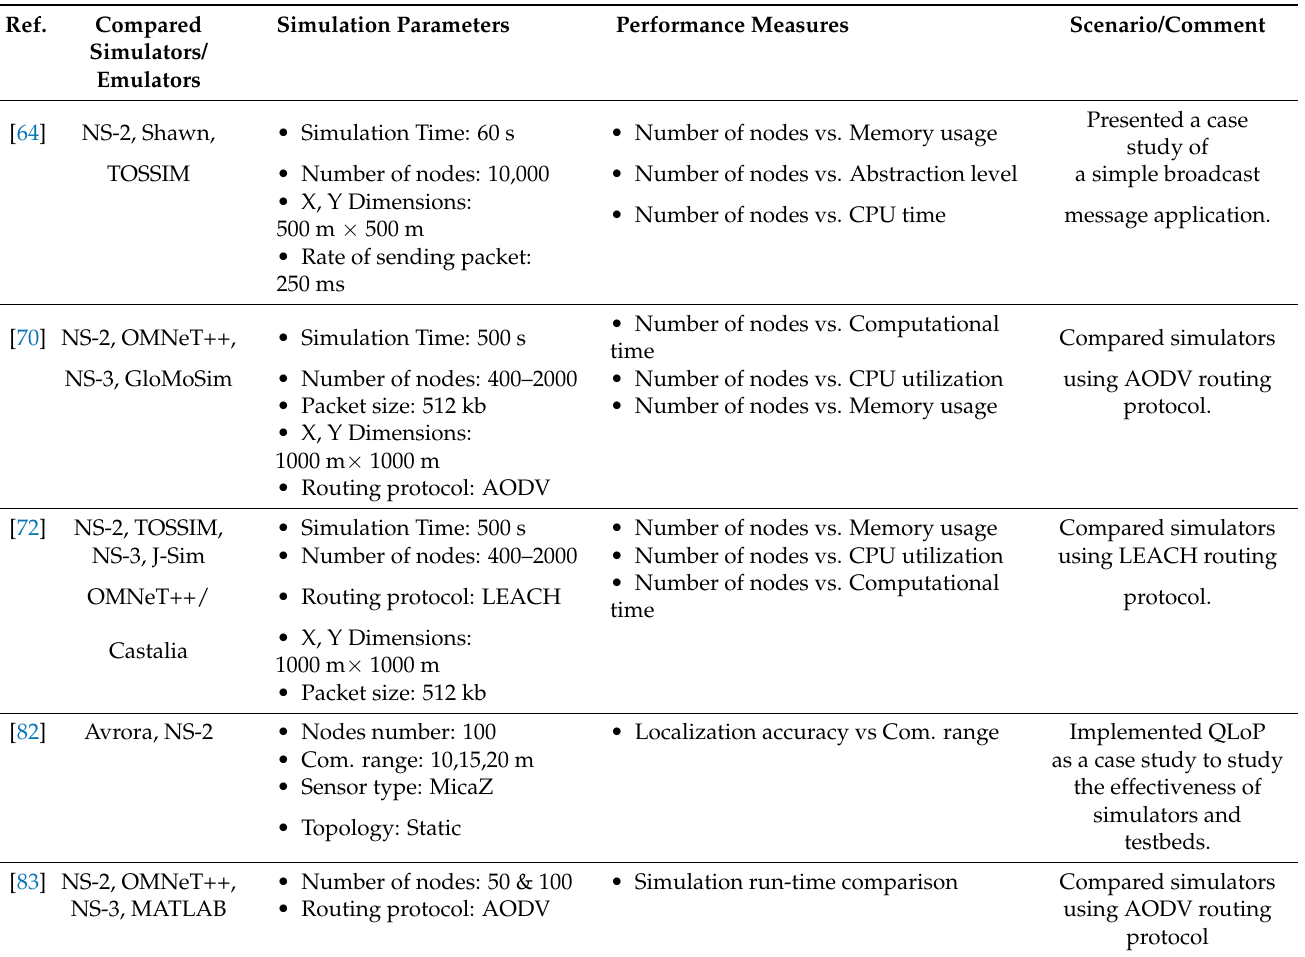
Table 2. Comparative Performance of the Reviewed Studies